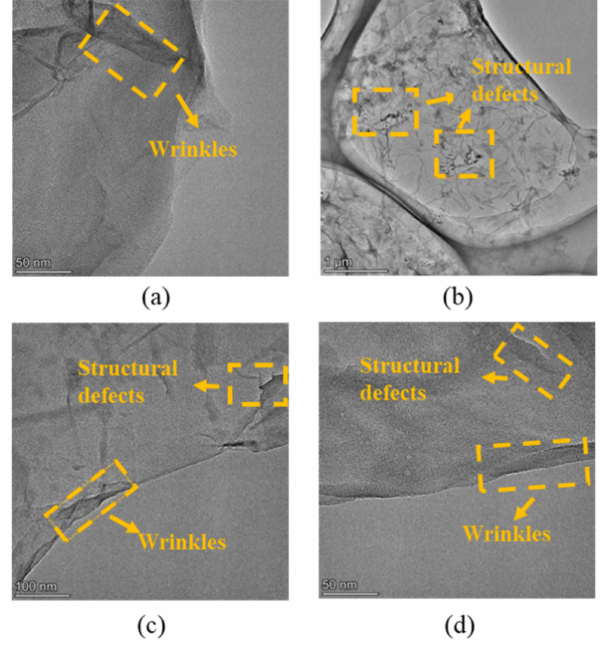
Figure 7. TEM images: ( a ) GO; ( b – d ) rGO